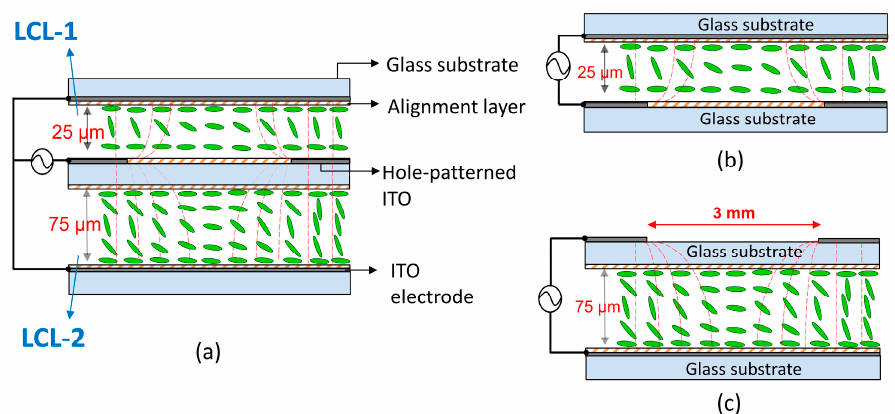
Figure 1. Schematic cross-section of the proposed LC lens and two major decomposed parts for the purpose of simulation design: ( a ) The proposed structure of the TLCL LC lens; ( b ) Decomposed part one (LCL-1); ( c ) Decomposed part two (LCL-2).